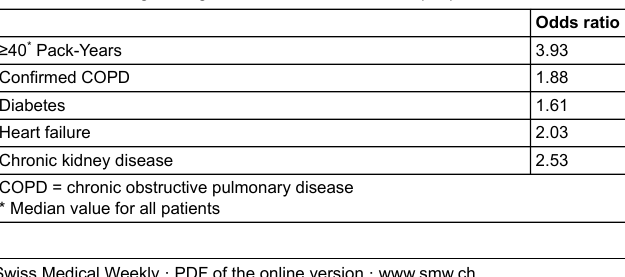
Table 6: Nominal logistic regression of the association of peripheral arterial disease with